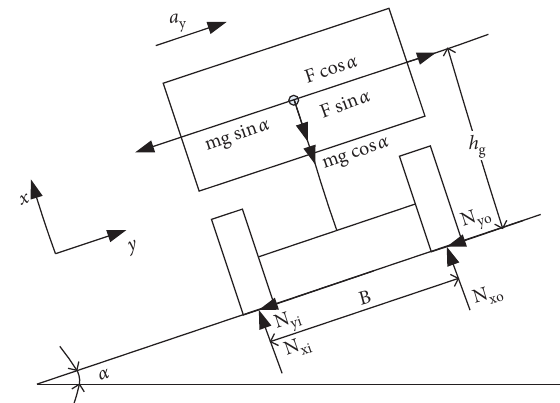
Figure 6: The free-body diagram of the quasistatic model of a rigid